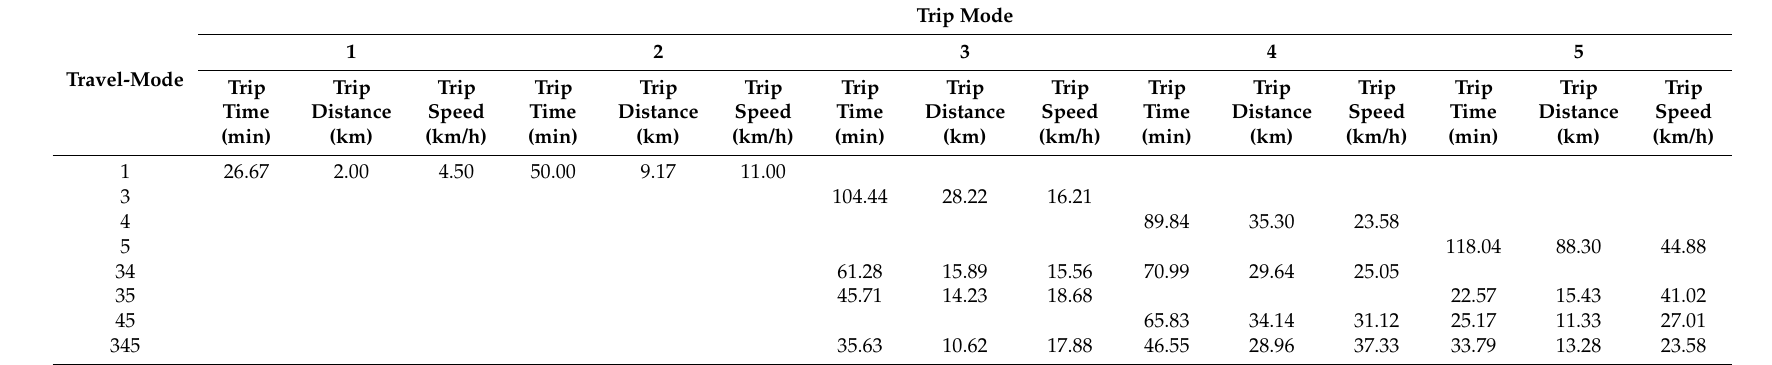
Table 8. Frequency distribution of trip characteristics over different travel-mode